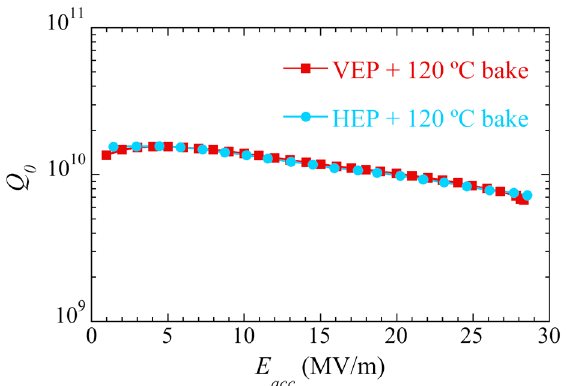
FIG. 24. SRF performances ( Q 0 versus E TB9-TSB01 at 2 K in vertical tests after an average removal of 130 μ m, including bulk and light removals, in both HEP and VEP processes. The tests were performed after post-light EP baking at 120 °C for 48